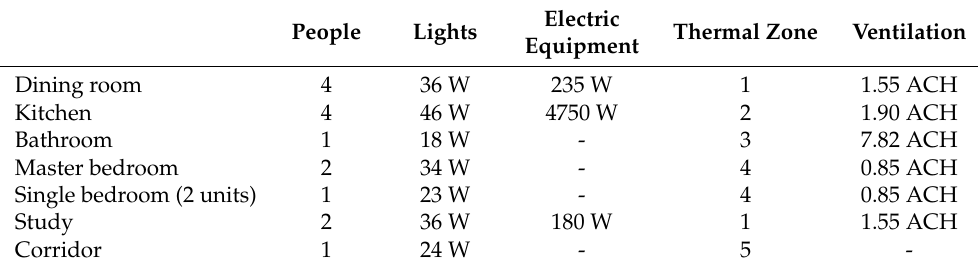
Table 4. Internal loads of people, lights (W) and electric equipment (W) applicable to each room. Thermal zone with which each room is associated and designed with natural ventilation (ACH). Electric Thermal Zone Ventilation People Lights Equipment